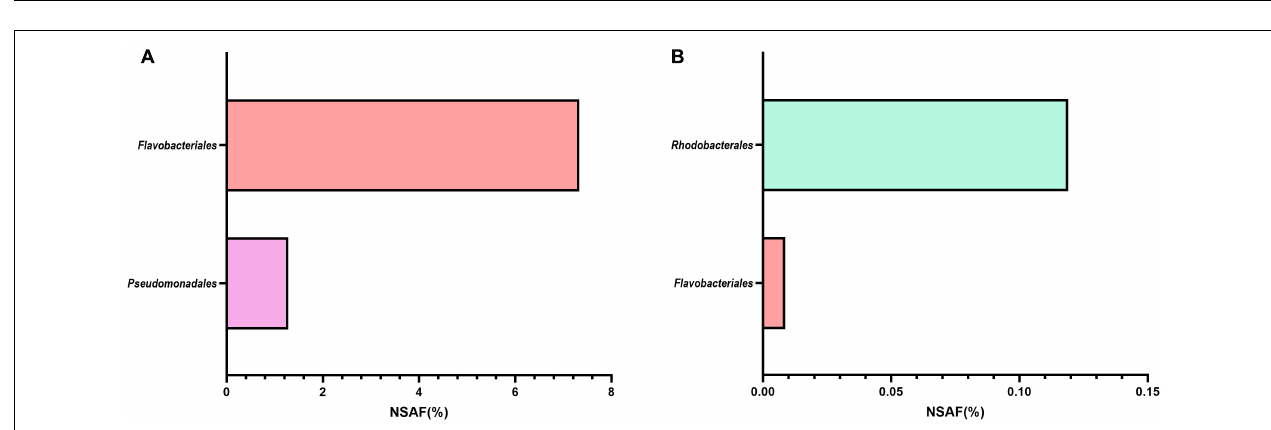
FIGURE 1 | Top ten most abundant protein categories in the 2010 – 2012 metaproteomes. Each point represents the log of the relative abundances of all the proteins (cumulative%NSAF) that belong to a particular category during a specific year (symbol color) and phase of the bloom (symbol shape) and among the four most abundant taxonomic groups. Bloom phases were determined based on chl a concentration as reported in Teeling et al. (2016) ( Supplementary Table 1 ). The box plots provide descriptive statistics of all datapoints for a specific category.